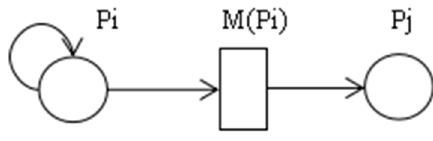
Figure 5. Timing rules.